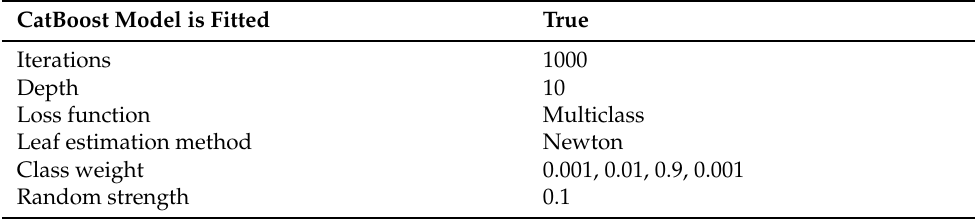
Table 4. CatBoost Classifier training